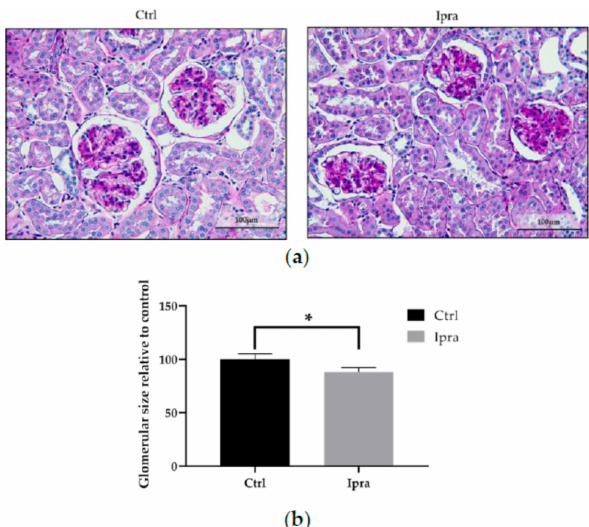
Figure 2. E ff ect of ipragliflozin on glomerular size. ( a ) Representative images of Periodic acid-Schi ff staining on FLS- ob / ob mouse kidney para ffi n-embedded sections. ( b ) Quantification of glomerular size. The results were expressed as the Bowman’s capsule area relative to control group. The quantification is based on at least 20 glomeruli from 6 di ff erent mice in each group. Bars indicate average ± SEM.